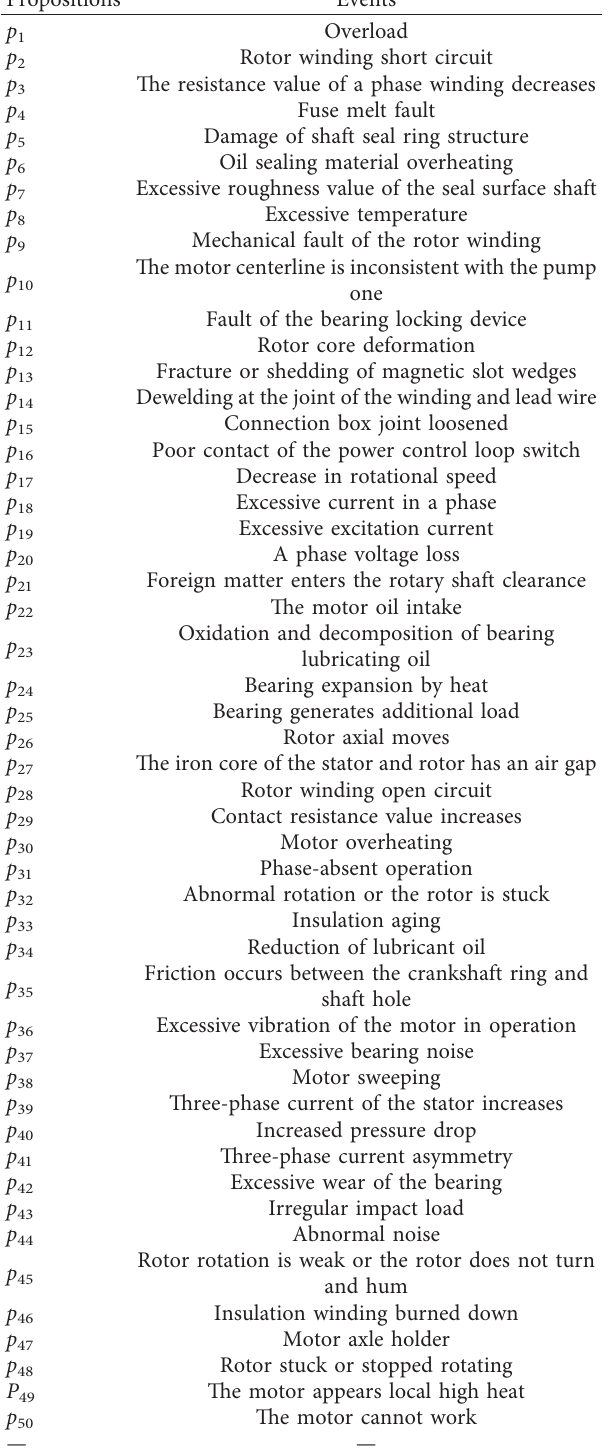
Table 1: The meaning of propositions in fuzzy fault production